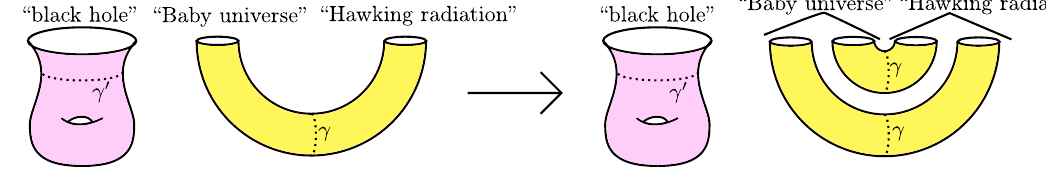
Figure 6 . The \black hole evaporation process" for our second model. Each step adds an additional copy of the thermo(cid:12)eld double state connecting a \baby universe" CFT and a \Hawking radiation" CFT. (cid:13) 0 is the extremal area surface near the original black hole exterior, and in this model it plays a role analogous to that of the new quantum extremal surface found in [4{6], but it is null- homologous so it is never the HRT surface for either the \black hole" CFT or the \radiation" CFTs. Indeed the HRT surface for the radiation CFTs is always (cid:13) . We have added a handle to the initial black hole to model whatever pure-state matter we collapsed to form it, in the last step this handle will disappear and the black hole system will be left in